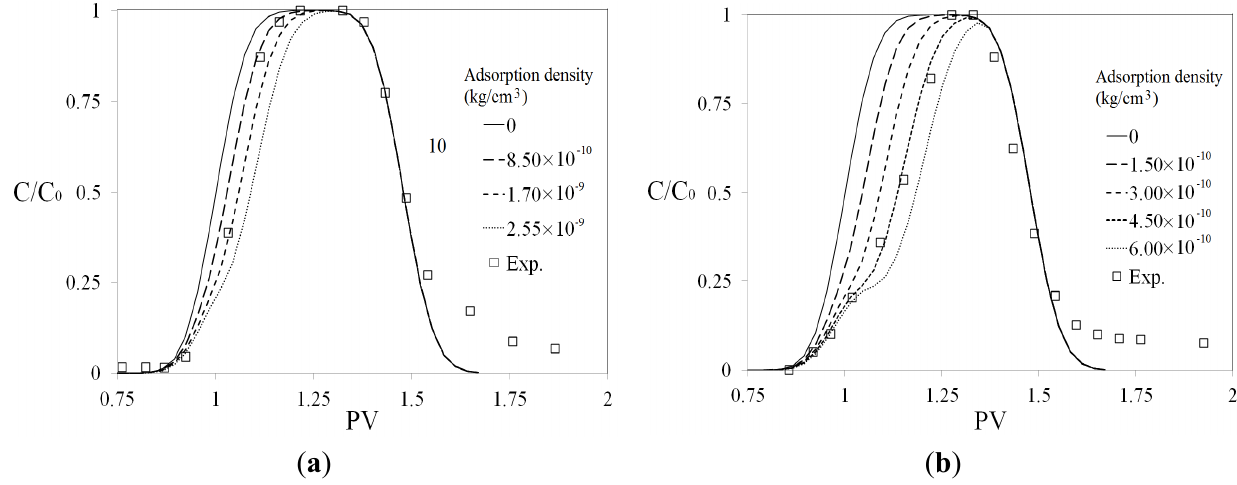
Figure 6. Comparison between the normalized effluent concentration data for 0.48 PV slug of Na-silicate solutions having silicon (Si) concentrations of: ( a ) 33 mg/L (0.0093 wt% Na-silicate); and ( b ) 3.9 mg/L (0.0011 wt% Na-silicate) to determine the corresponding adsorption